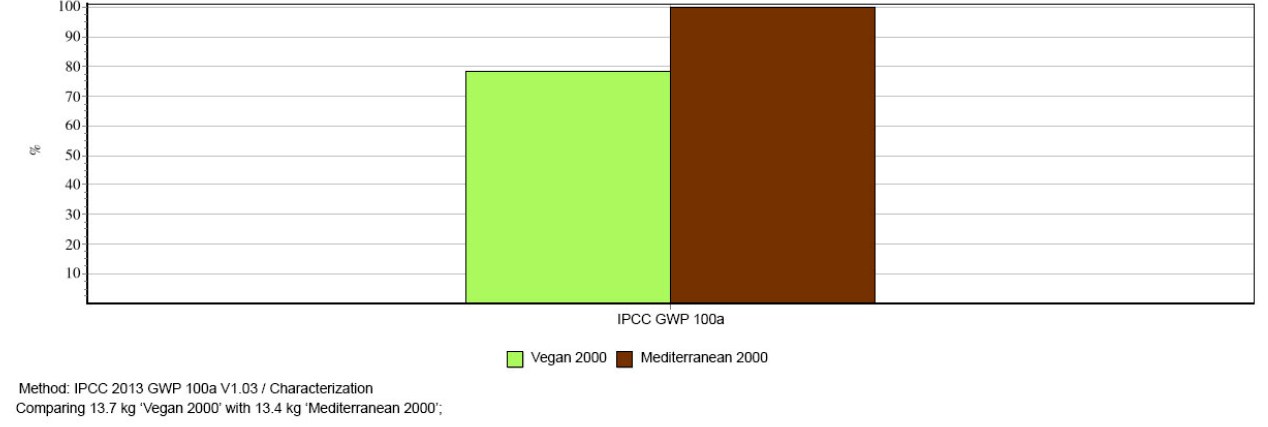
Figure A4. Comparison of the two diets’ impact according to IPCC 2013 (available from SimaPro ® ).